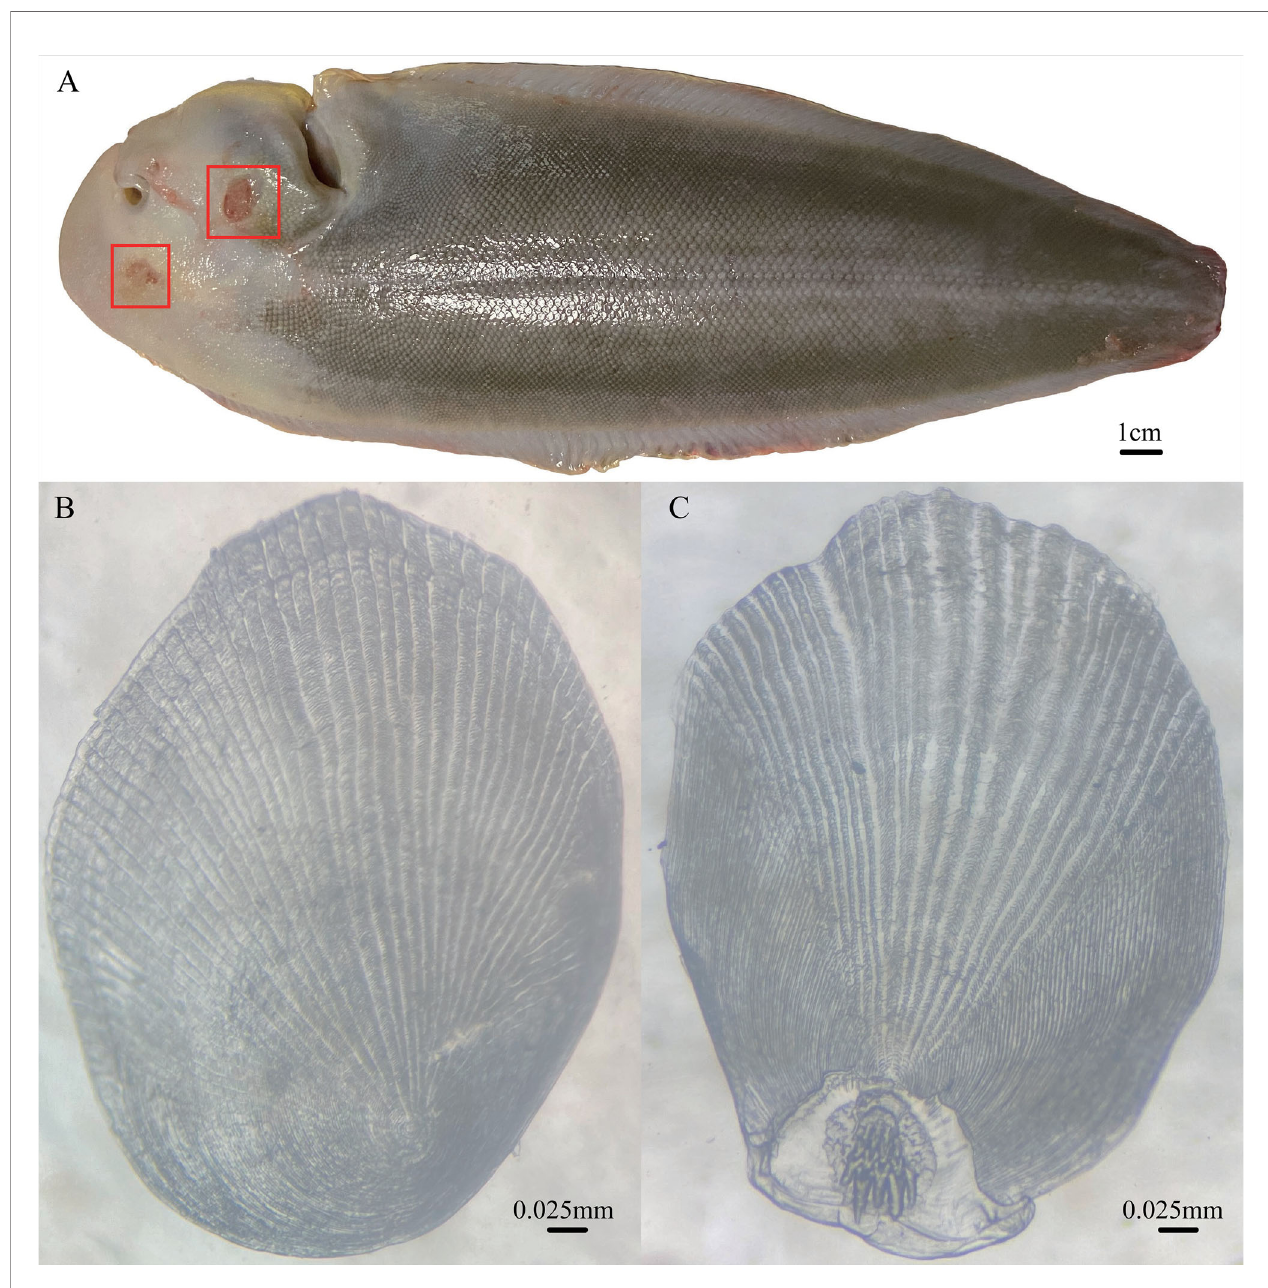
FIGURE 7 | (A) Blind-side hypermelanosis of tongue sole (15-month-old male) with wounds (red box). (B) Blind-side cycloid scale (from 15-month-old female tongue sole). (C) Blind-side ctenoid scale (from 15-month-old female tongue